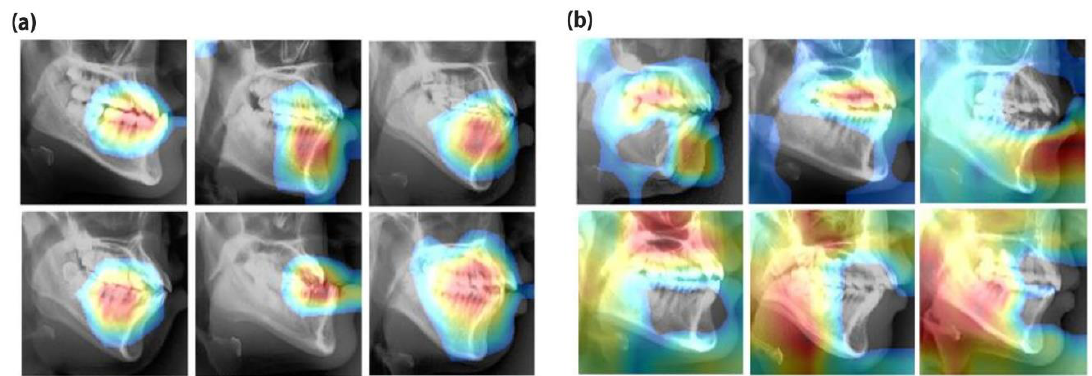
Figure 5. The region of interest of deep learning models using gradient-weighted class activation mapping. ( a ) Success cases. ( b ) Failure cases.